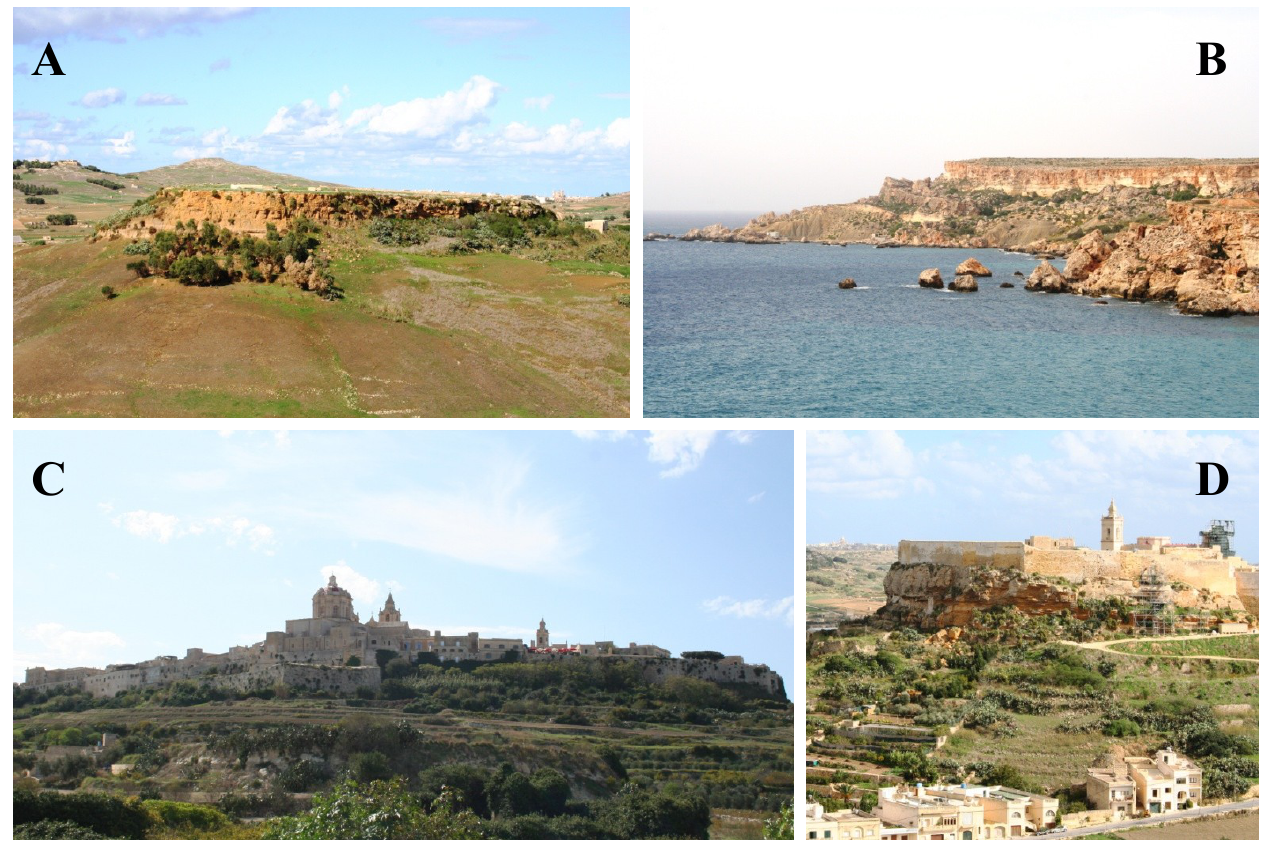
Fig. 3. Panoramic views of UCL slabs overlying BC exposed in Gozo (A) and Malta (B) , and of the investigated sites of Mdina (C) and Citadel (D)